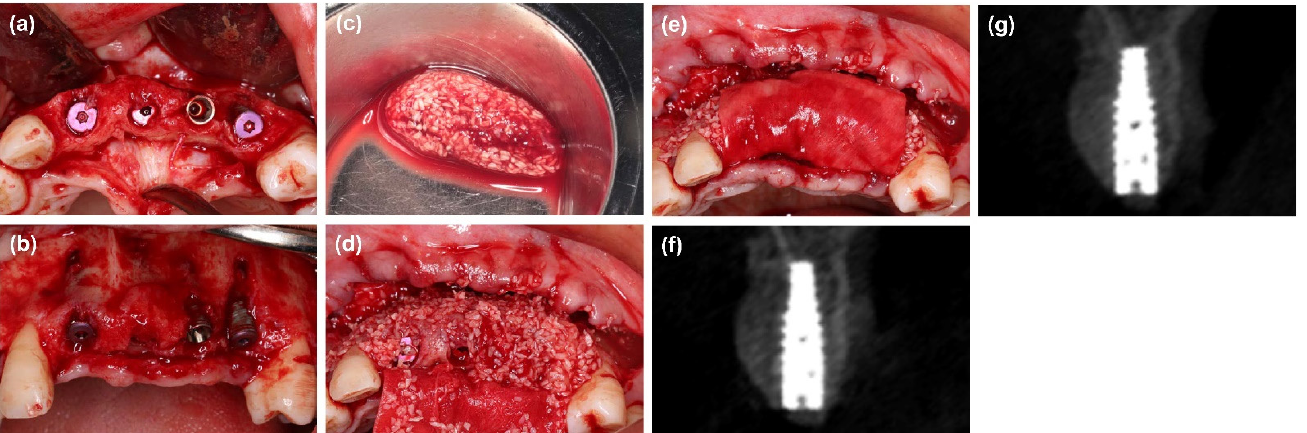
Figure 2. ( a , b ) The labial defect could be observed. ( c ) Particulate bone substitutes were mixed with i-PRF to form i-PRF blocks. ( d , e ) The i-PRF block was placed into the bone defect and covered with a collagen membrane, and titanium pins were used to fixate the membrane. ( f ) Radiographic cone-beam CT view immediately after wound closure. ( g ) Radiographic cone-beam CT view at 6 months.